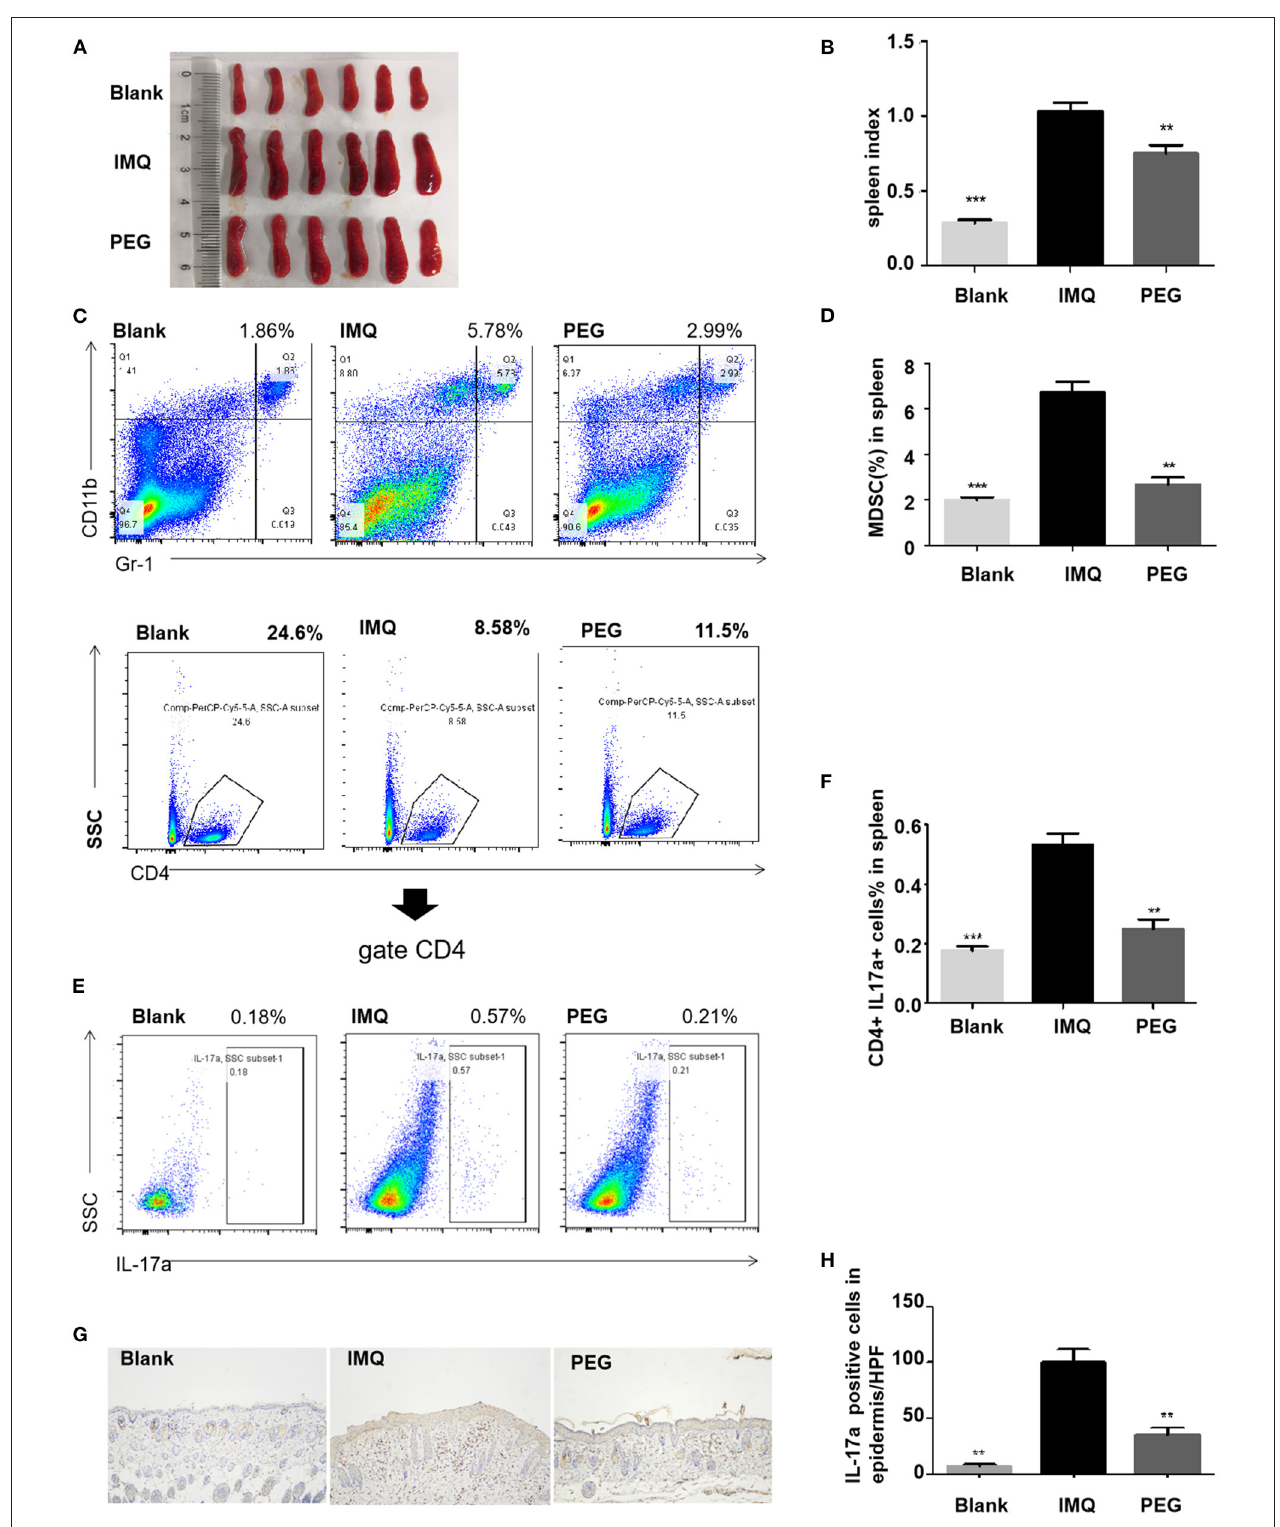
FIGURE 6 | (A,B) Spleen and statistical graph of all mice. (C–F) Flow analysis chart of spleen and statistical graph. (C,D) Percentage of MDSCs in the spleen of each group of mice and statistical graph. (E,F) Percentage of Th17 cells in the spleen of each group of mice and statistical graph. (G,H) Infiltration of IL-17A cells in dermal superficial of each group of mice and statistical graph. (*compared with the IMQ group, ** P < 0.01, *** P < 0.001). All statistical graph and data analysis were finished by GraphPad Prism 5 software. We have repeated the experiment more than three times.